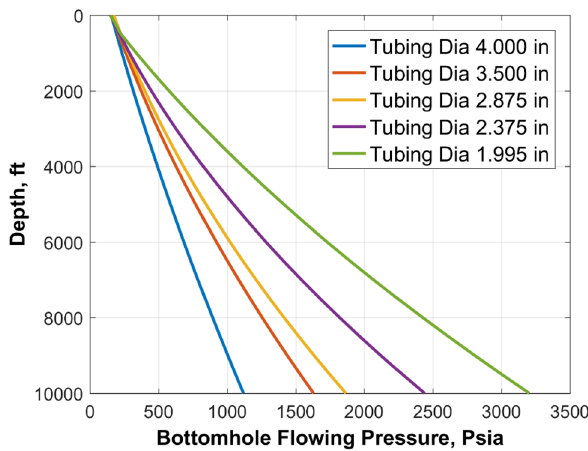
Fig. 11 Effect of changing depth on flowing bottom-hole pressure at tubing IDs of 1.995, 2.375, 2.875, 3.500 and 4.000 inches